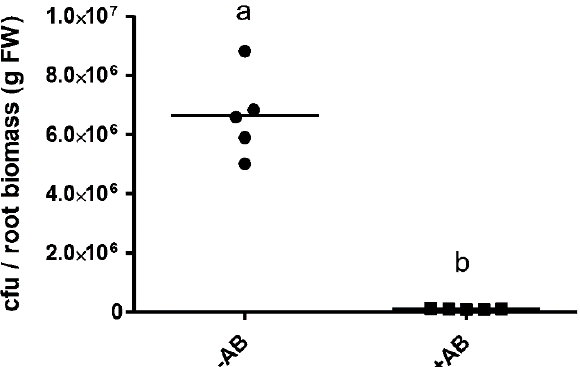
Figure 1. Effect of a 6 h antibiotic treatment of M. truncatula seeds on root-associated bacteria four days after germination. Bacterial abundance was estimated from culturable bacterial colonies and was normalized against the root biomass of each plant. Significant differences between the treatments are indicated with different letters; p < 0.05 (Student’s t -test). Abbreviations: cfu: colony-forming units; FW: fresh weight. For M. truncatula roots of this age, 1 g of fresh weight is equivalent to about 50 roots; thus, each root (approximately 4 cm long) in the − AB/+AB treatment groups would harbor on average around 120,000/2000 colony-forming units, respectively.